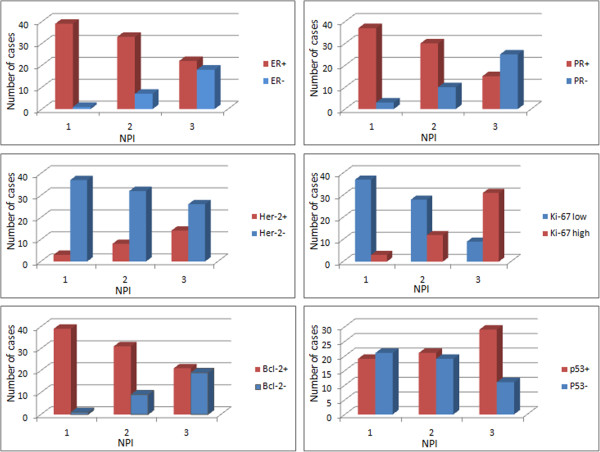
Expression of ER, PR, HER-2/neu, Ki-67, Bcl-2, and p53 in NPI groups.